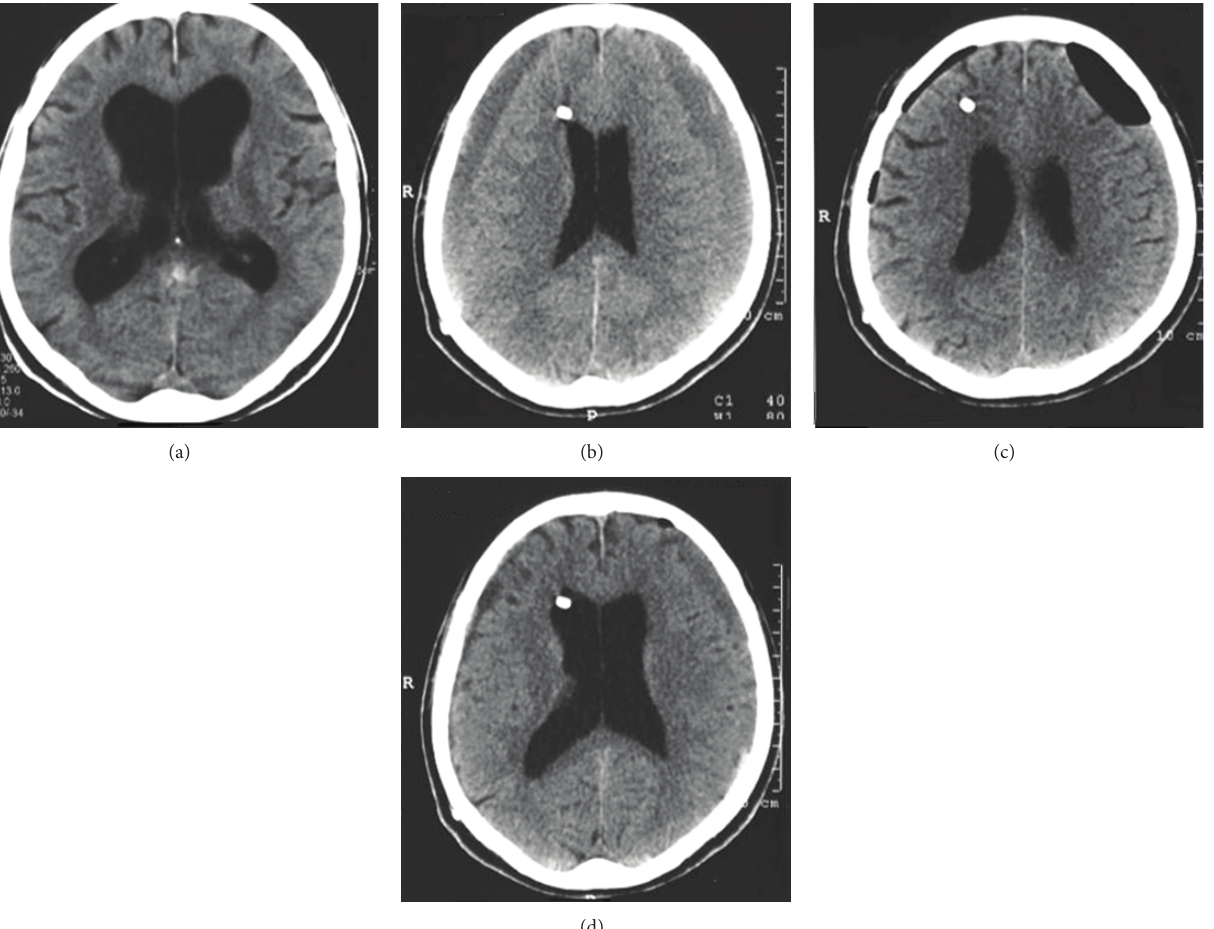
Figure 2: (a) CT scan showing a widened ventricular system. (b) CT scan 35 months after shunt implantation and bilateral traumatic chronic subdural hematomas were demonstrated. (c) Postoperative CT scan 2 days after surgical drainage and adjustment of the opening pressure. (d) CT scan two weeks after the adjustment. The hematomas were almost